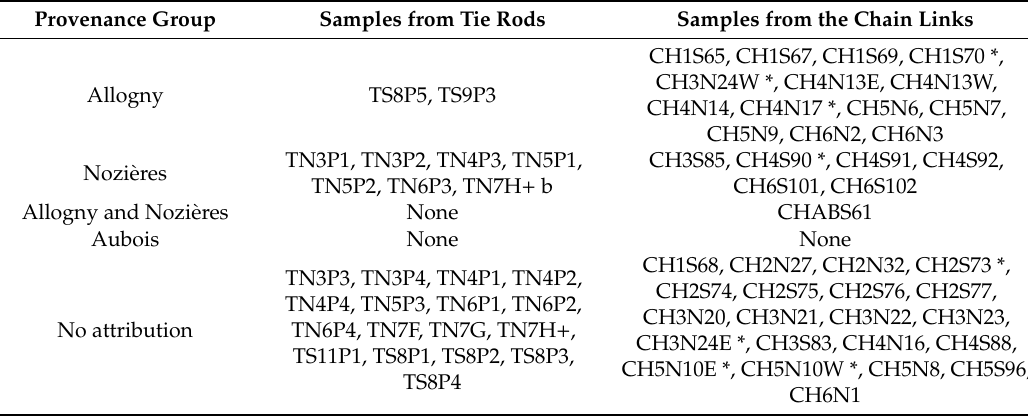
Figure 11. Provenance groups of the artefacts located in the cathedral, tie rods parts—each provenance corresponds to a given part of the bar, links of the triforium chain (* = recycled, ? = unknown provenance). Table 4. Results of the LDA analyses comparing one single artefact with a single production area (* indicates recycled samples characterized by metallographic and elemental